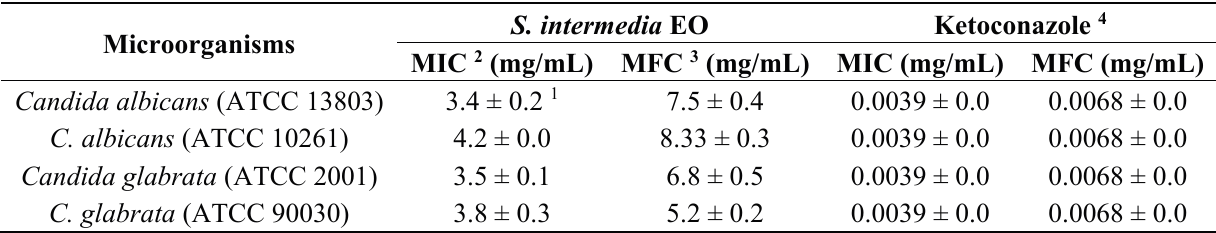
Table 4. Antifungal activity of Satureja intermedia C.A.Mey essential oil